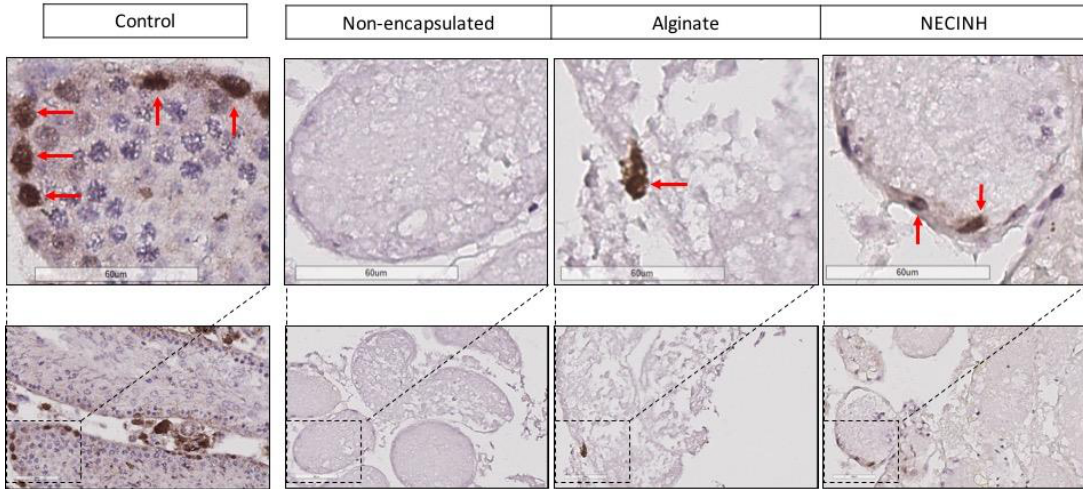
Figure 4. Impact of NECINH-nanoparticles-loaded hydrogel on mice testicular tissue exposed to hypoxia (1% O 2 ) for 21 days. Undifferentiated spermatogonial survival. Promyelocytic leukemia zinc finger (PLZF) + cells are highlighted by red arrows.